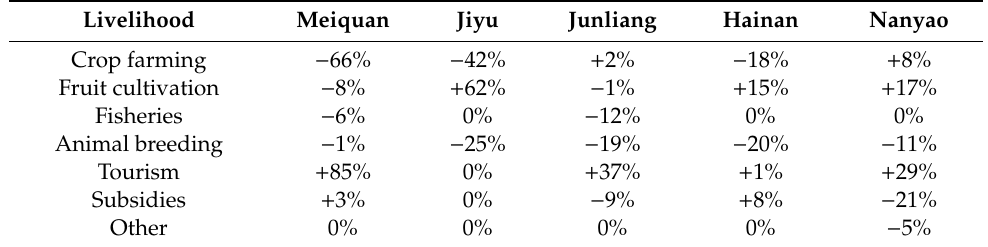
Table 4. Changes in the income structures of the surveyed villages in Lashi Township from 2005 to 2015. Livelihood Meiquan Jiyu Junliang Hainan Nanyao Crop